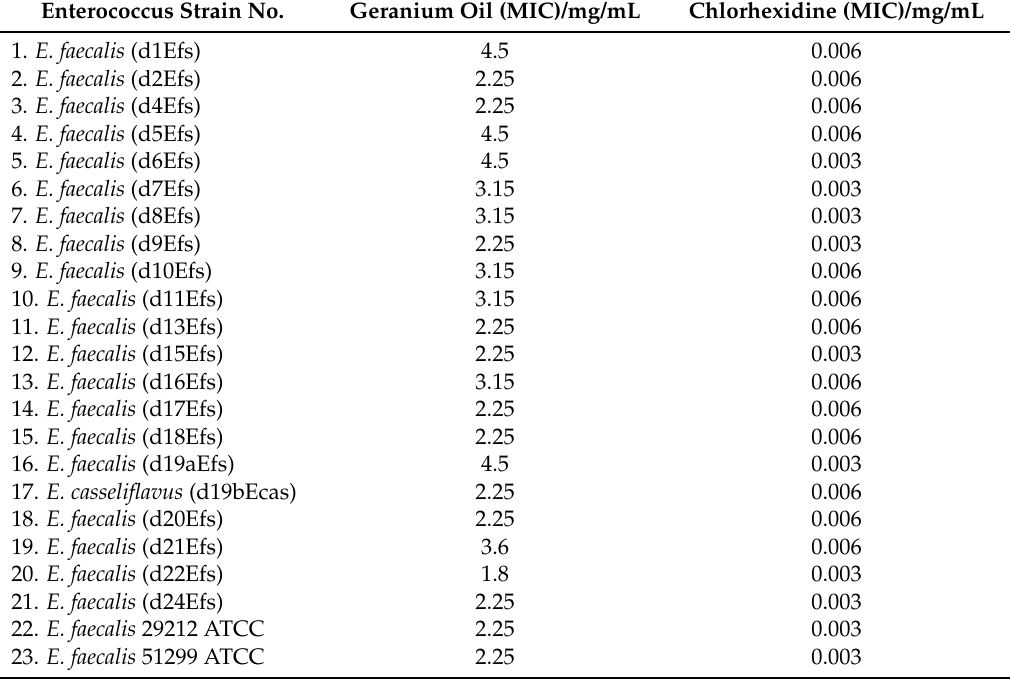
Table 2. Susceptibility of Enterococcus strains to geranium oil and chlorhexidine. Enterococcus Strain